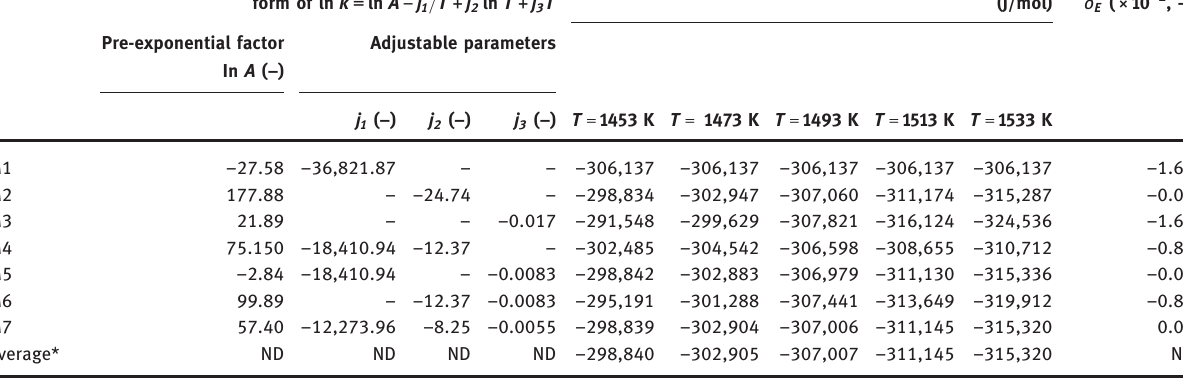
Table 4: Regressed results of pre-exponential factor ln A , adjustable parameters j 1 , j 2 , and j 3 , apparent activation energy E of crystallization, and mean deviation δ E based on seven collected formulas of k . Formula No. Regressed results of parameters in expression of k